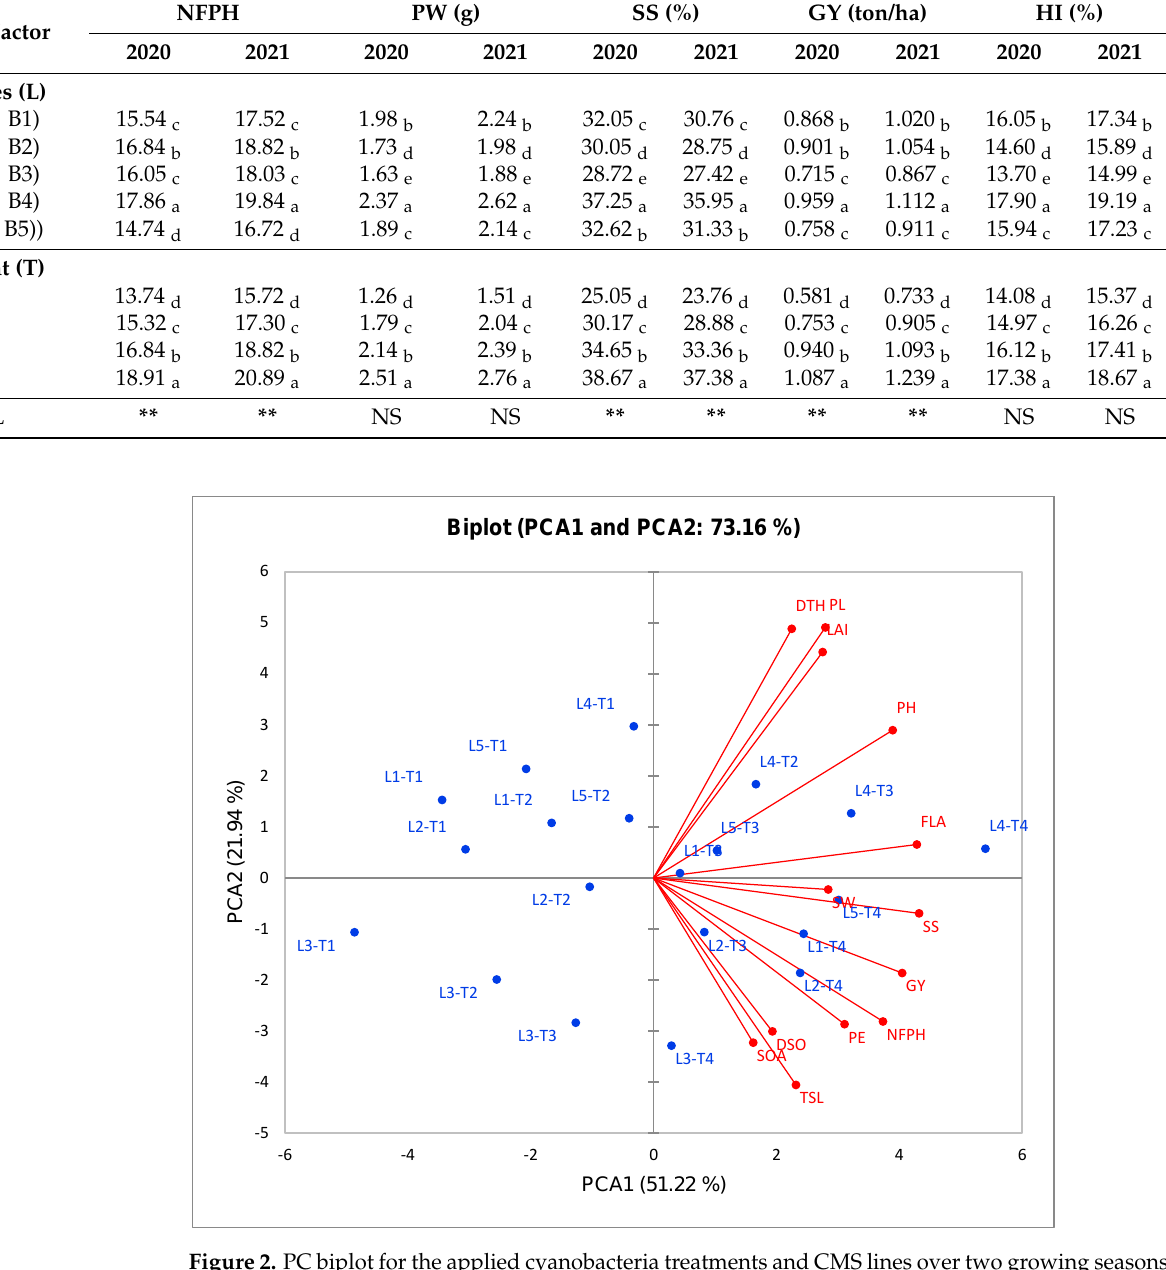
Figure 2. PC biplot for the applied cyanobacteria treatments and CMS lines over two growing seasons, depending on evaluated traits. DTH: days to heading, DSO: duration of spikelet opening, PE: panicle exertion, PW: panicle weight, SS: seed set, GY: grain yield, TSL: total stigma length, SOA: spikelet opening angle, SW: stigma width, LAI: leaf area index, NFPH: number of fertile panicles per hill, FLA: flag leaf angle, PH: plant height, PL: panicle length, and HI: harvest index.